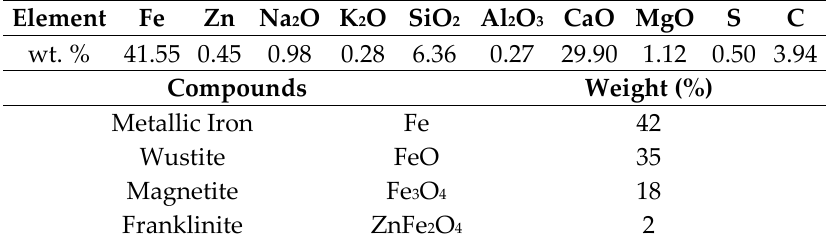
Figure 2. SEM / EDS micrograph of the BFS. Table 4. Chemical analysis of the blast furnace sludge (BFS) and mineralogical reconstruction of the Fe compounds.